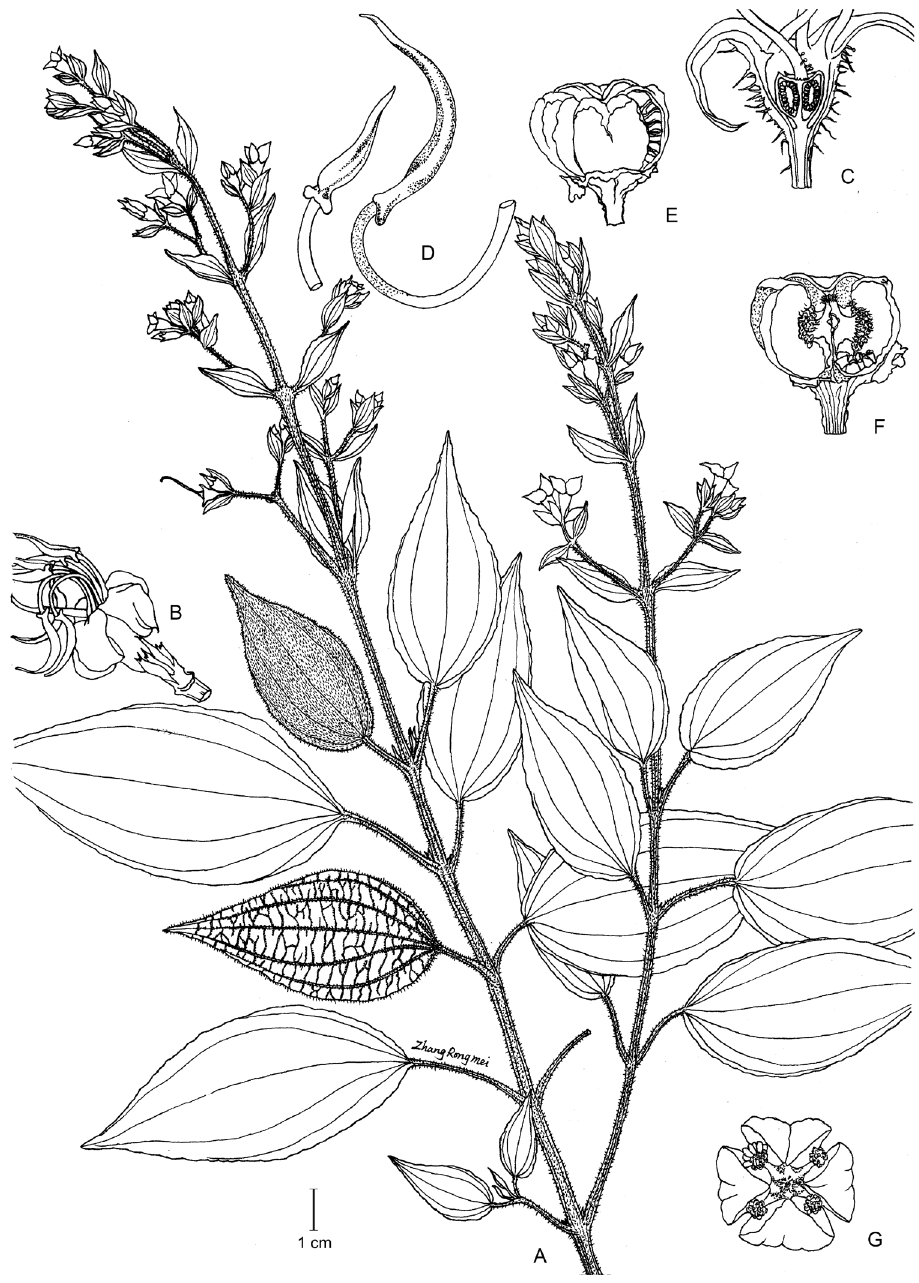
Figure 10. Line illustration of Tashiroea villosa ( A–G ), all from Y. Liu 568 . A Habit B Flower (side view) C Longitudinal section of flower, showing slightly crowned ovary D Dimorphic stamens E Capsule (side view) F Capsule (longitudinal section) G Capsule (top view). Scale bar: 1 cm ( A